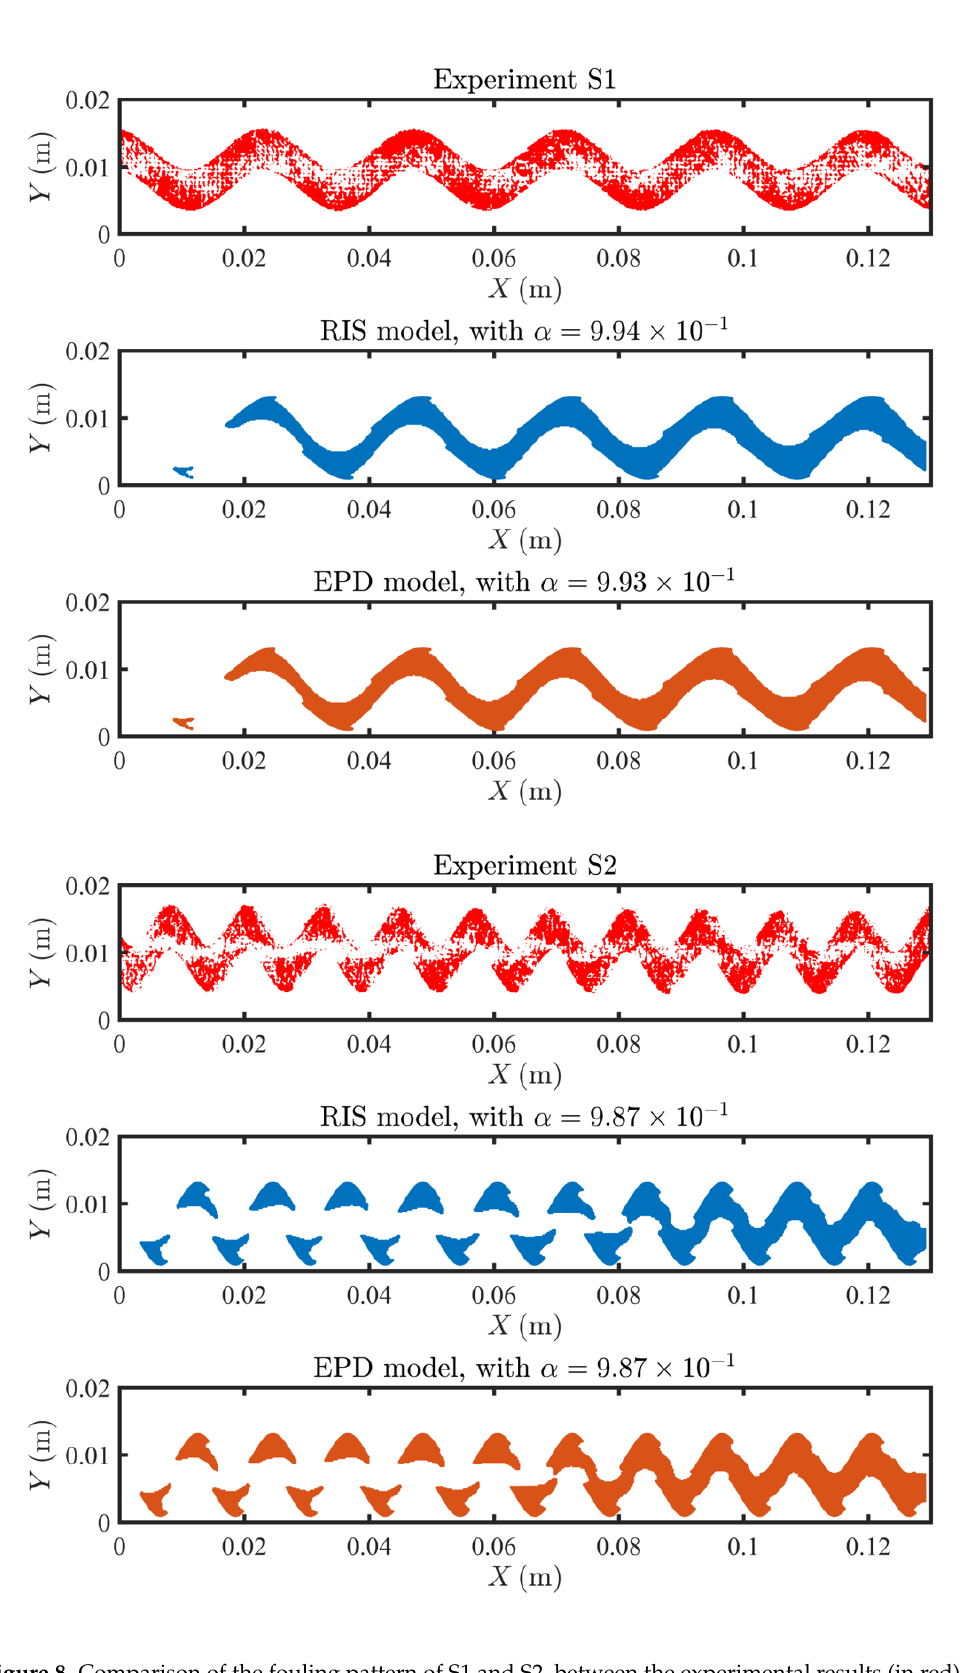
Figure 8. Comparison of the fouling pattern of S1 and S2, between the experimental results (in red), the RIS model simulation results (in blue) and the EPD model (in